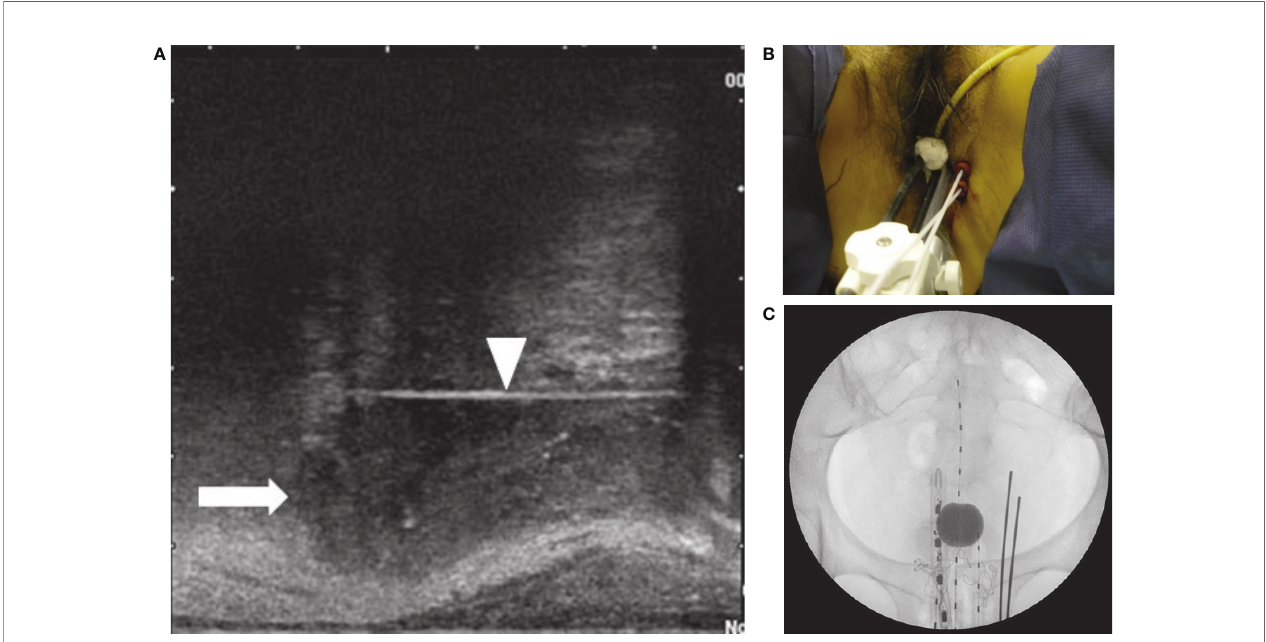
FIGURE 2 | (A) Sagittal view of the transrectal ultrasound showing the parametrial invasion (arrow) and the interstitial perineal applicator (arrowhead). The applicator is inserted up to the cranial margin of the parametrial invasion. (B) Two perineal interstitial applicators were inserted to the left of intracavitary applicators. (C) Anterior x-ray of intracavitary and interstitial applicators. Also seen is a rectal